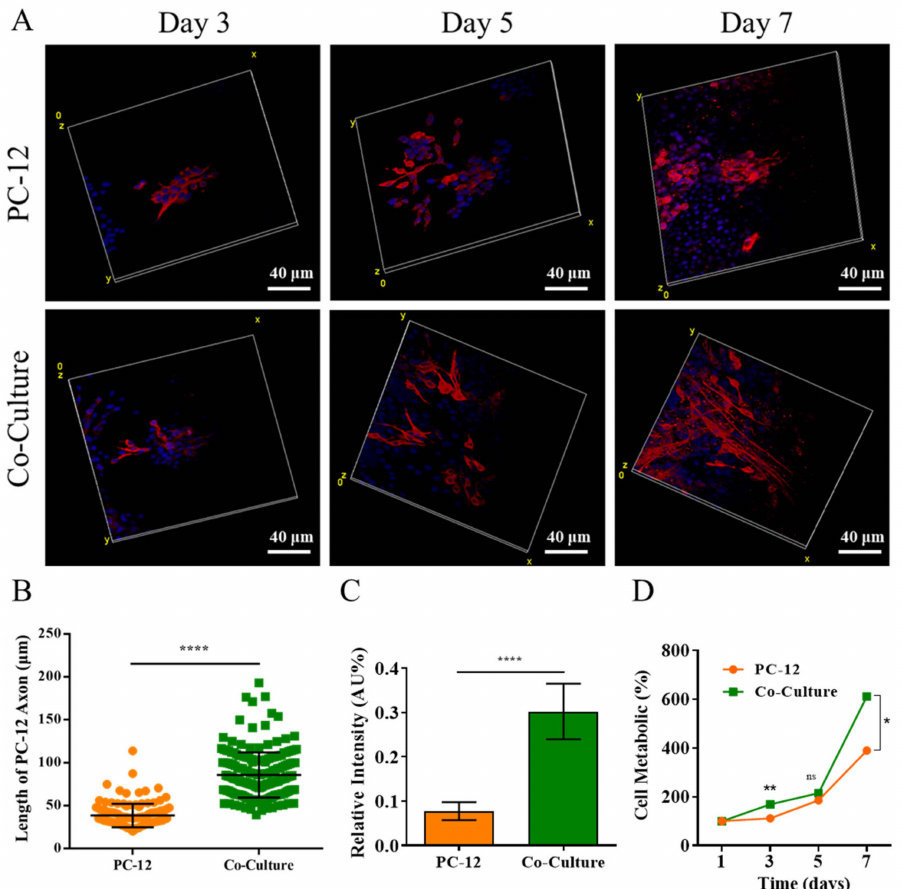
Figure 5. PC-12 cells proliferation and immunofluorescent staining in a co-culture system. ( A ) Confo- cal laser microscopy images of PC-12 cells stained with β III tubulin (red) and cell nuclei (blue) after co-culture with SCs 3, 5, and 7 days. ( B ) Statistical axons of PC-12 cells. ( C ) Statistical immunofluo- rescent area of β III tubulin. ( D ) Cck-8 result of PC-12 proliferation. * p < 0.05, **** p <